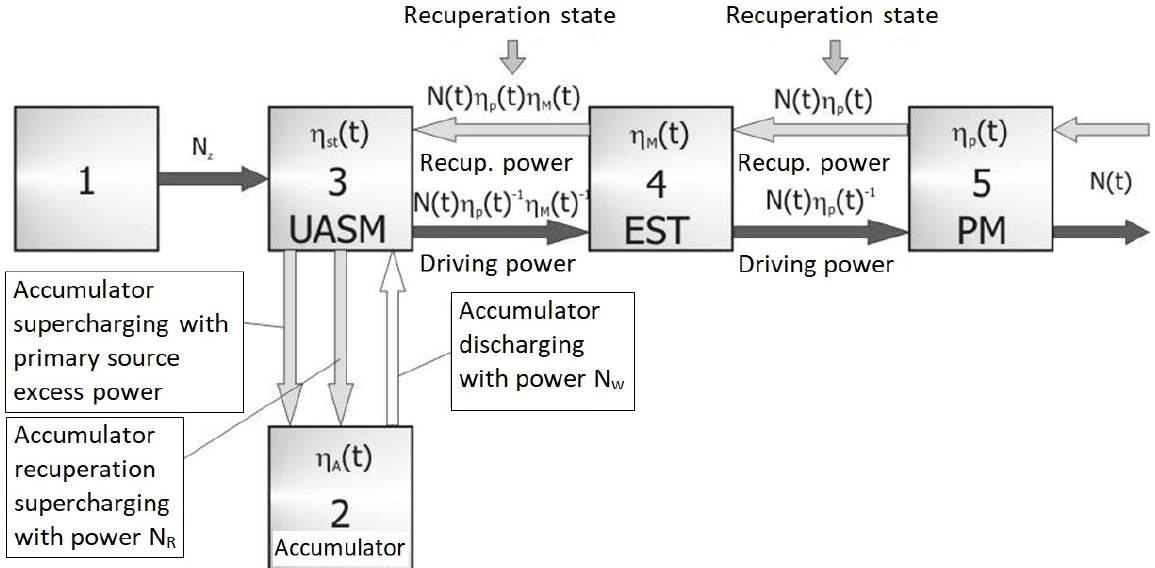
Figure 4. Block diagram of hybrid drive system: 1: primary energy source; 2: energy accumulator; 3: automatic power control system (UASM); 4: electric traction motor (EST); 5: mechanical gearbox (PM) ( N : power; η : efficiency; t : time; indexes: z : primary source of energy; st : control system; M